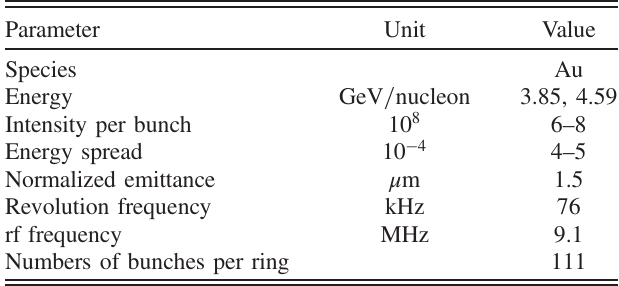
TABLE II. Ion beam parameters used during electron cooling commissioning at